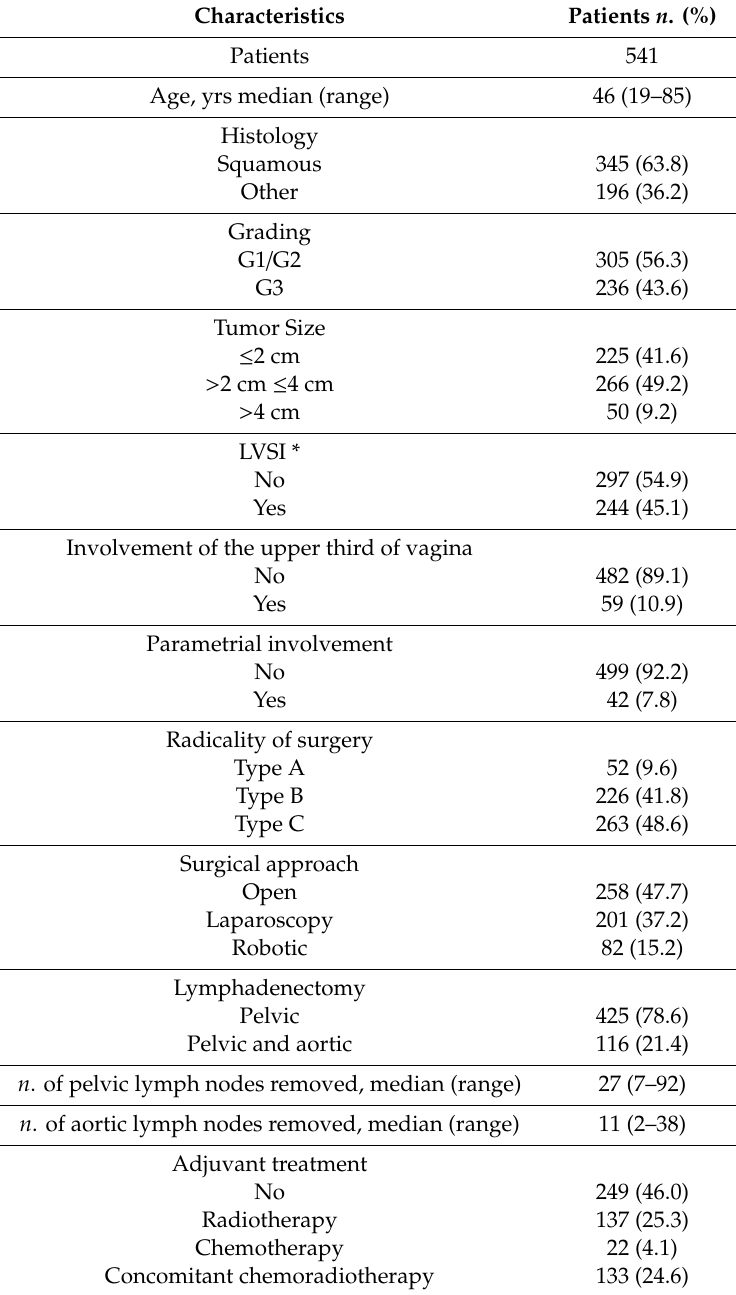
Table 1. Main features of the